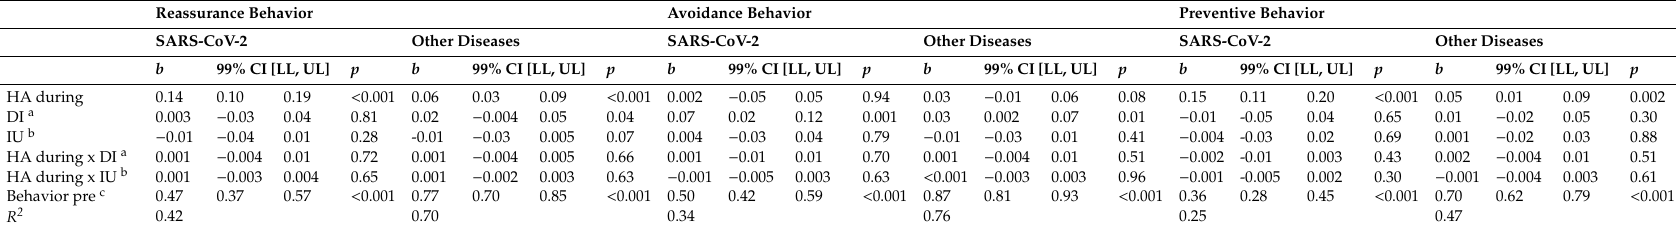
Table 5. Results of the moderator analyses on behavior during COVID-19 with health anxiety (SHAI) during COVID-19 as predictor and intolerance of uncertainty [IU-18] and distress intolerance [Distress intolerance scale] as moderators. Reassurance Behavior Avoidance Behavior Preventive Behavior SARS-CoV-2 Other Diseases SARS-CoV-2 Other Diseases SARS-CoV-2 HA